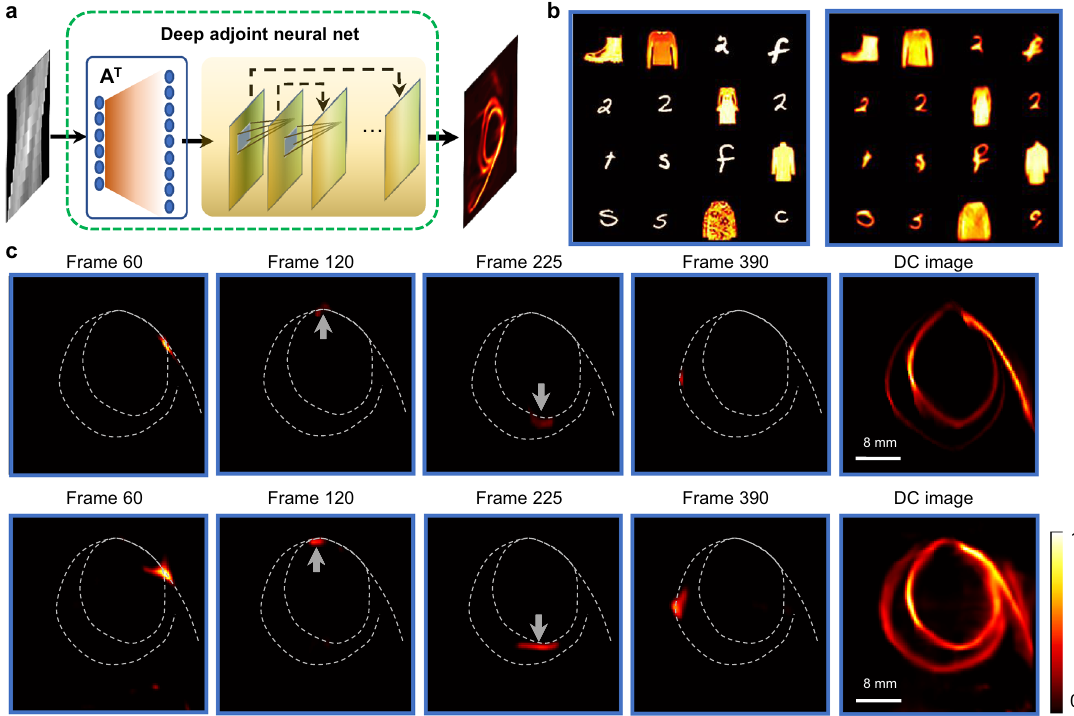
Fig. 3 Deep adjoint neural network for LIFT reconstruction. a The network architecture of DANN. The measurement data is fi rstly processed by the adjoint operator A T of the system and then passed to a convolutional network with skip connections. The detailed network structure and parameters are provided in Supplementary Note 8. b DANN reconstruction results of a subset of the experimentally measured test images, arranged in a montage format with an image fi eld of view ~36 mm. Left: ground truth images; Right: DANN reconstruction. c Comparison of image reconstruction results using iterative methods (top row) and DANN (bottom row). The helical fi ber structure is crafted and overlaid in each frame for visual